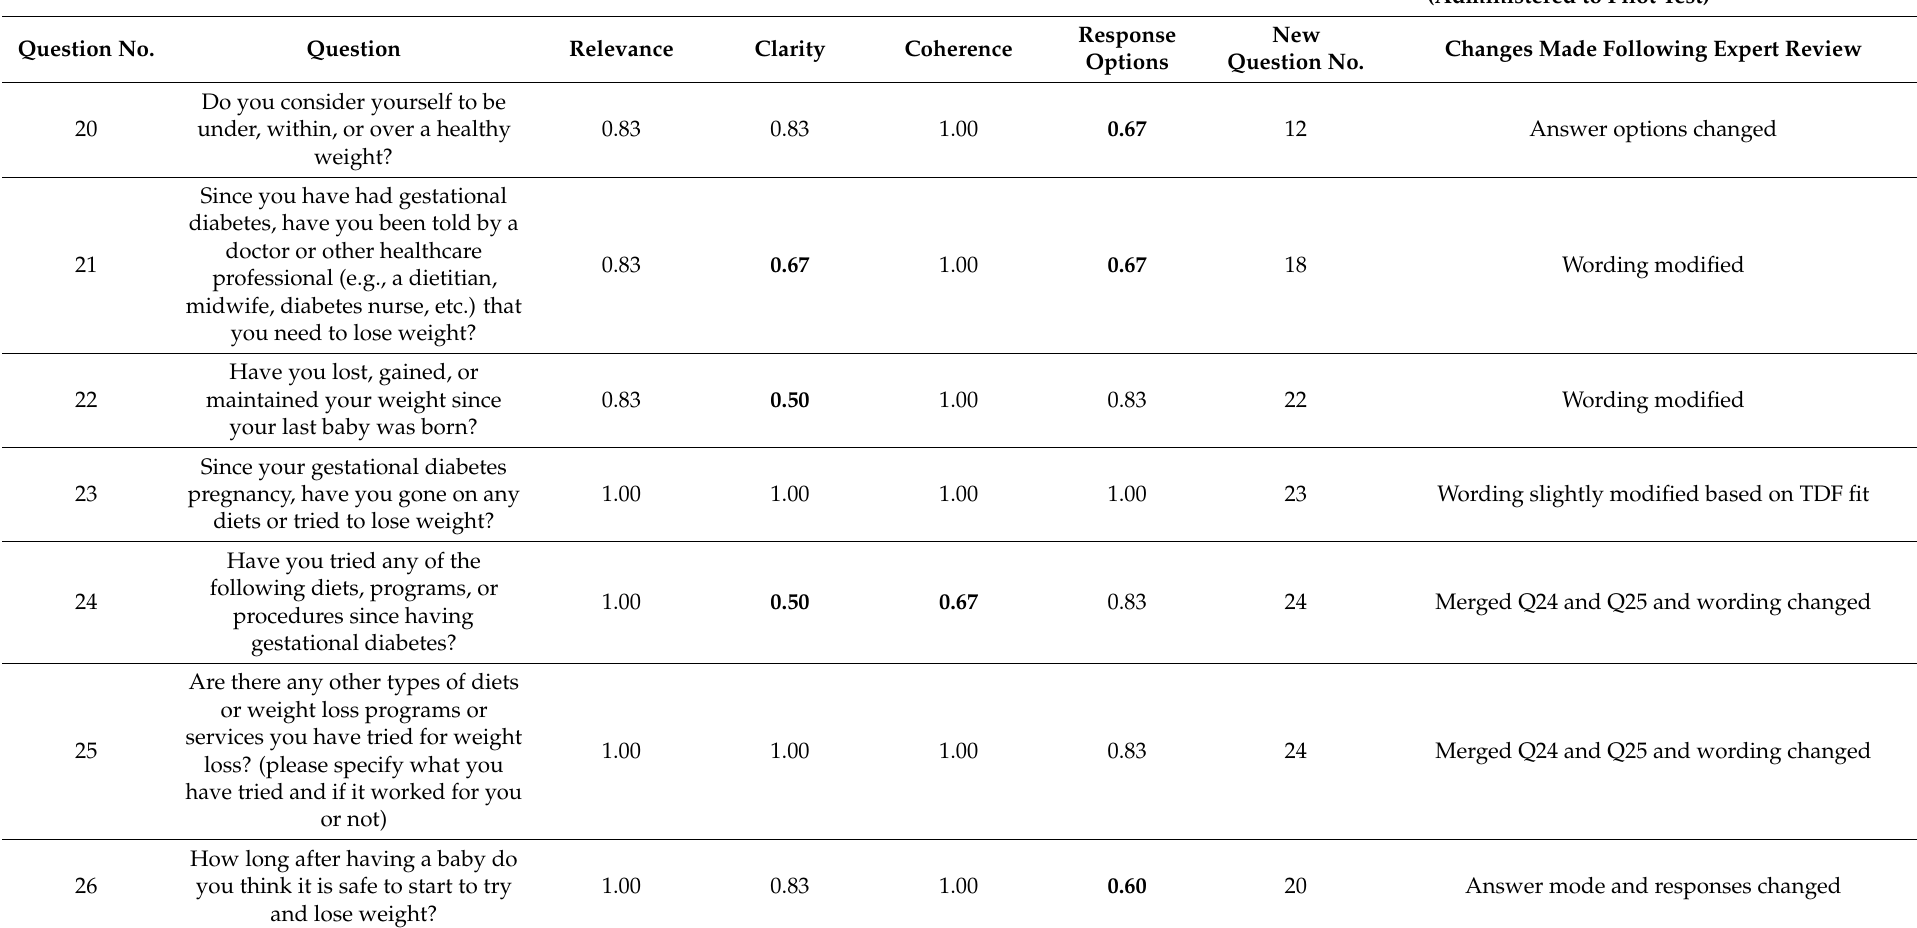
Version 1 of Survey: Items Constructed by the Research